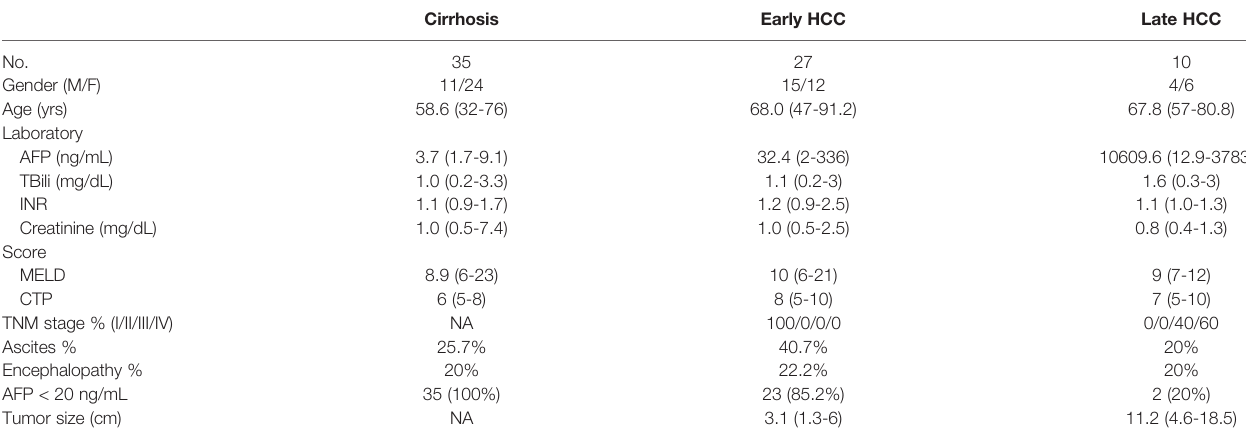
TABLE 1 | Clinical characteristics of individual patients with NASH for PRM